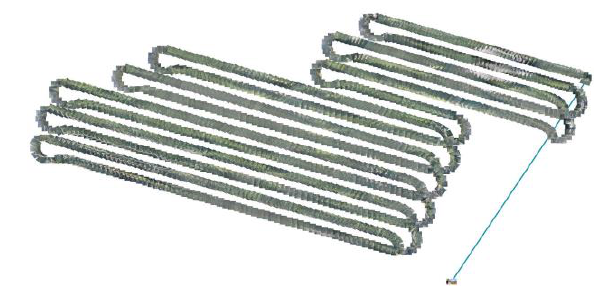
Figure 5 Tracking map with thumbnail photos rotated.